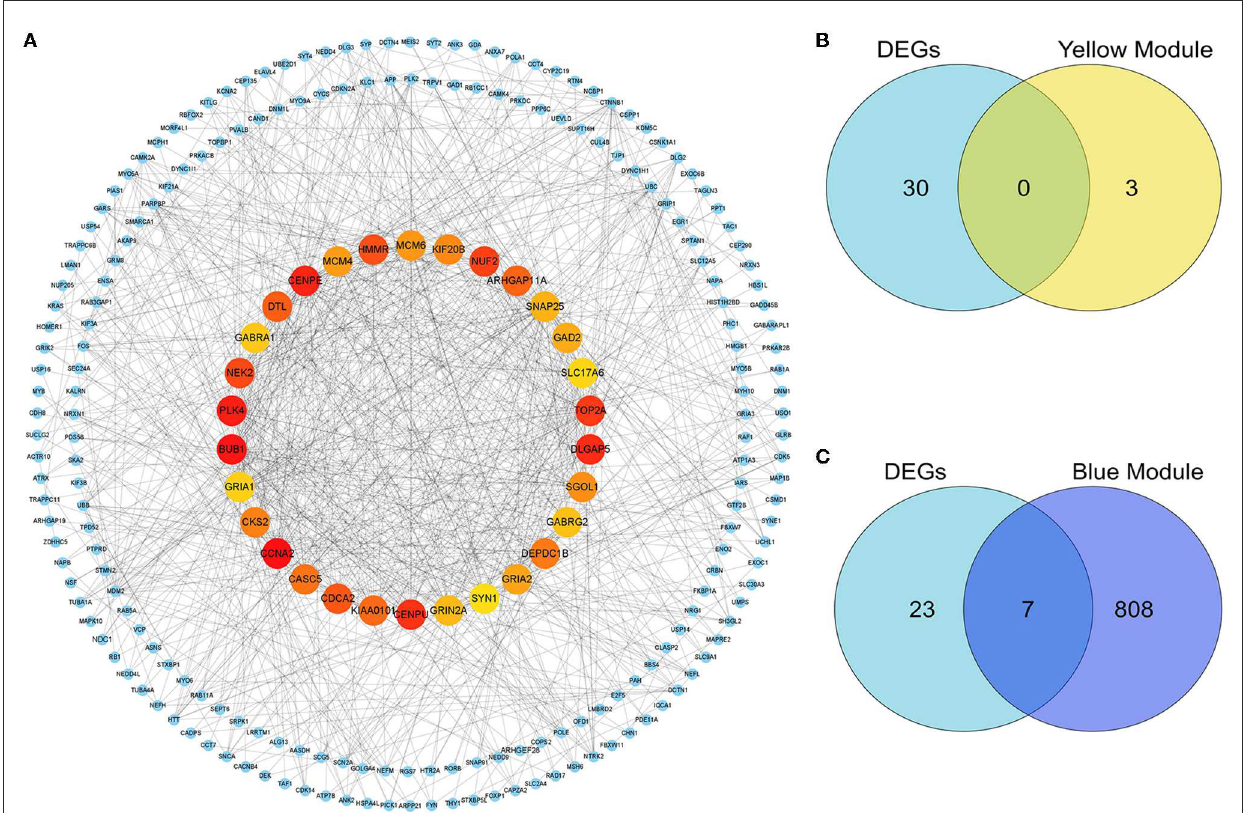
FIGURE6 Identification of the hub genes and key genes. The PPI network of the DEGs. (A) The top 30 hub genes among DEGs were confirmed with the Cytohubba plugin. The colors of the nodes reflect the degree of connectivity, the darker the yellow color, the more obvious the connectivity is. The key genes are defined as the hub genes identified by both the DEG-PPI network and the WGCNA method. (B) The hub genes in DEGs and the yellow module are shown using a Venn diagram. No key genes were identified. (C) The hub genes in DEGs and the blue module are shown using a Venn diagram. Seven key genes were